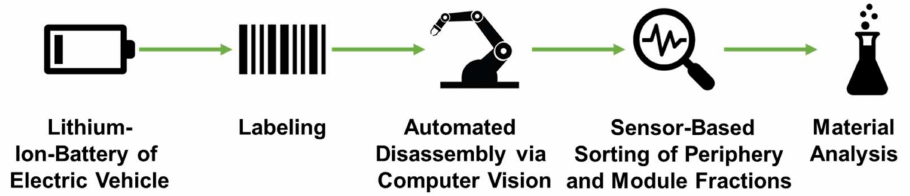
Figure 1. Course of action in